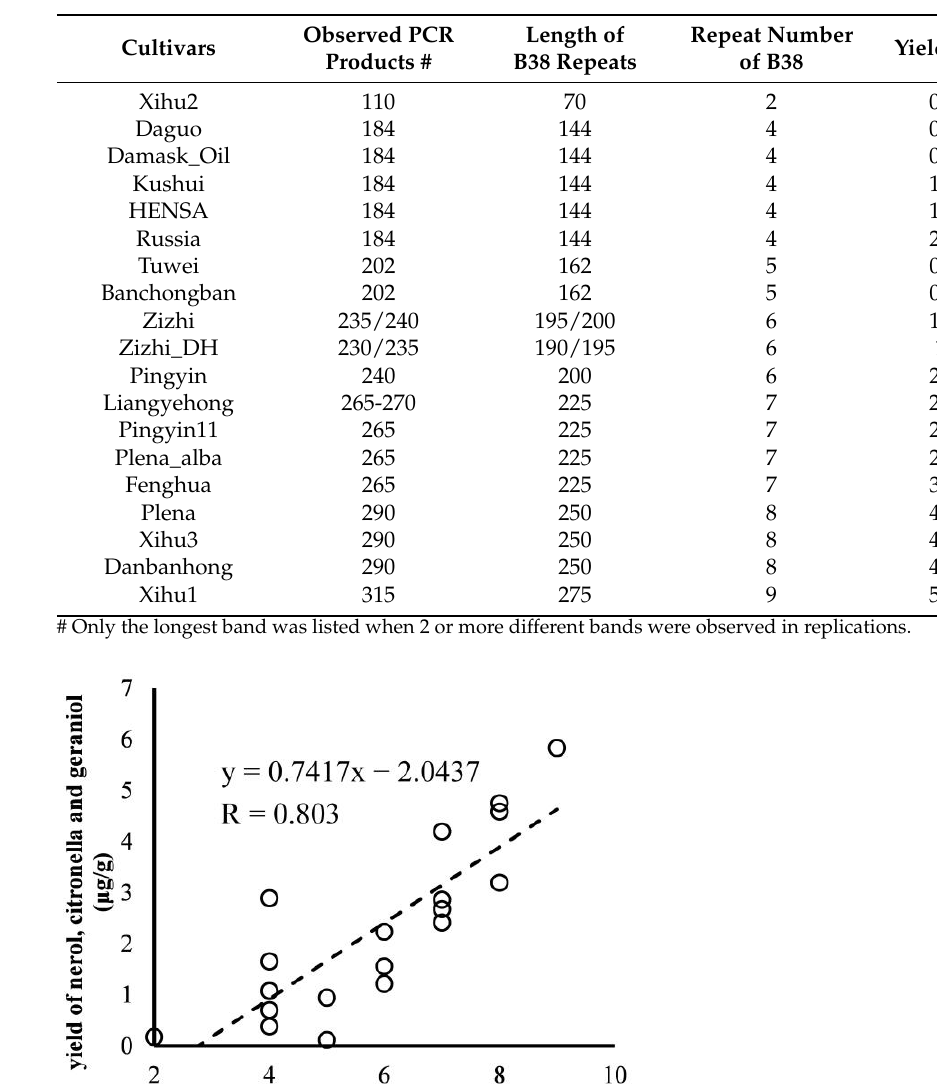
Table 1. B38 repeats polymorphism and oil yield of oil bearing roses.